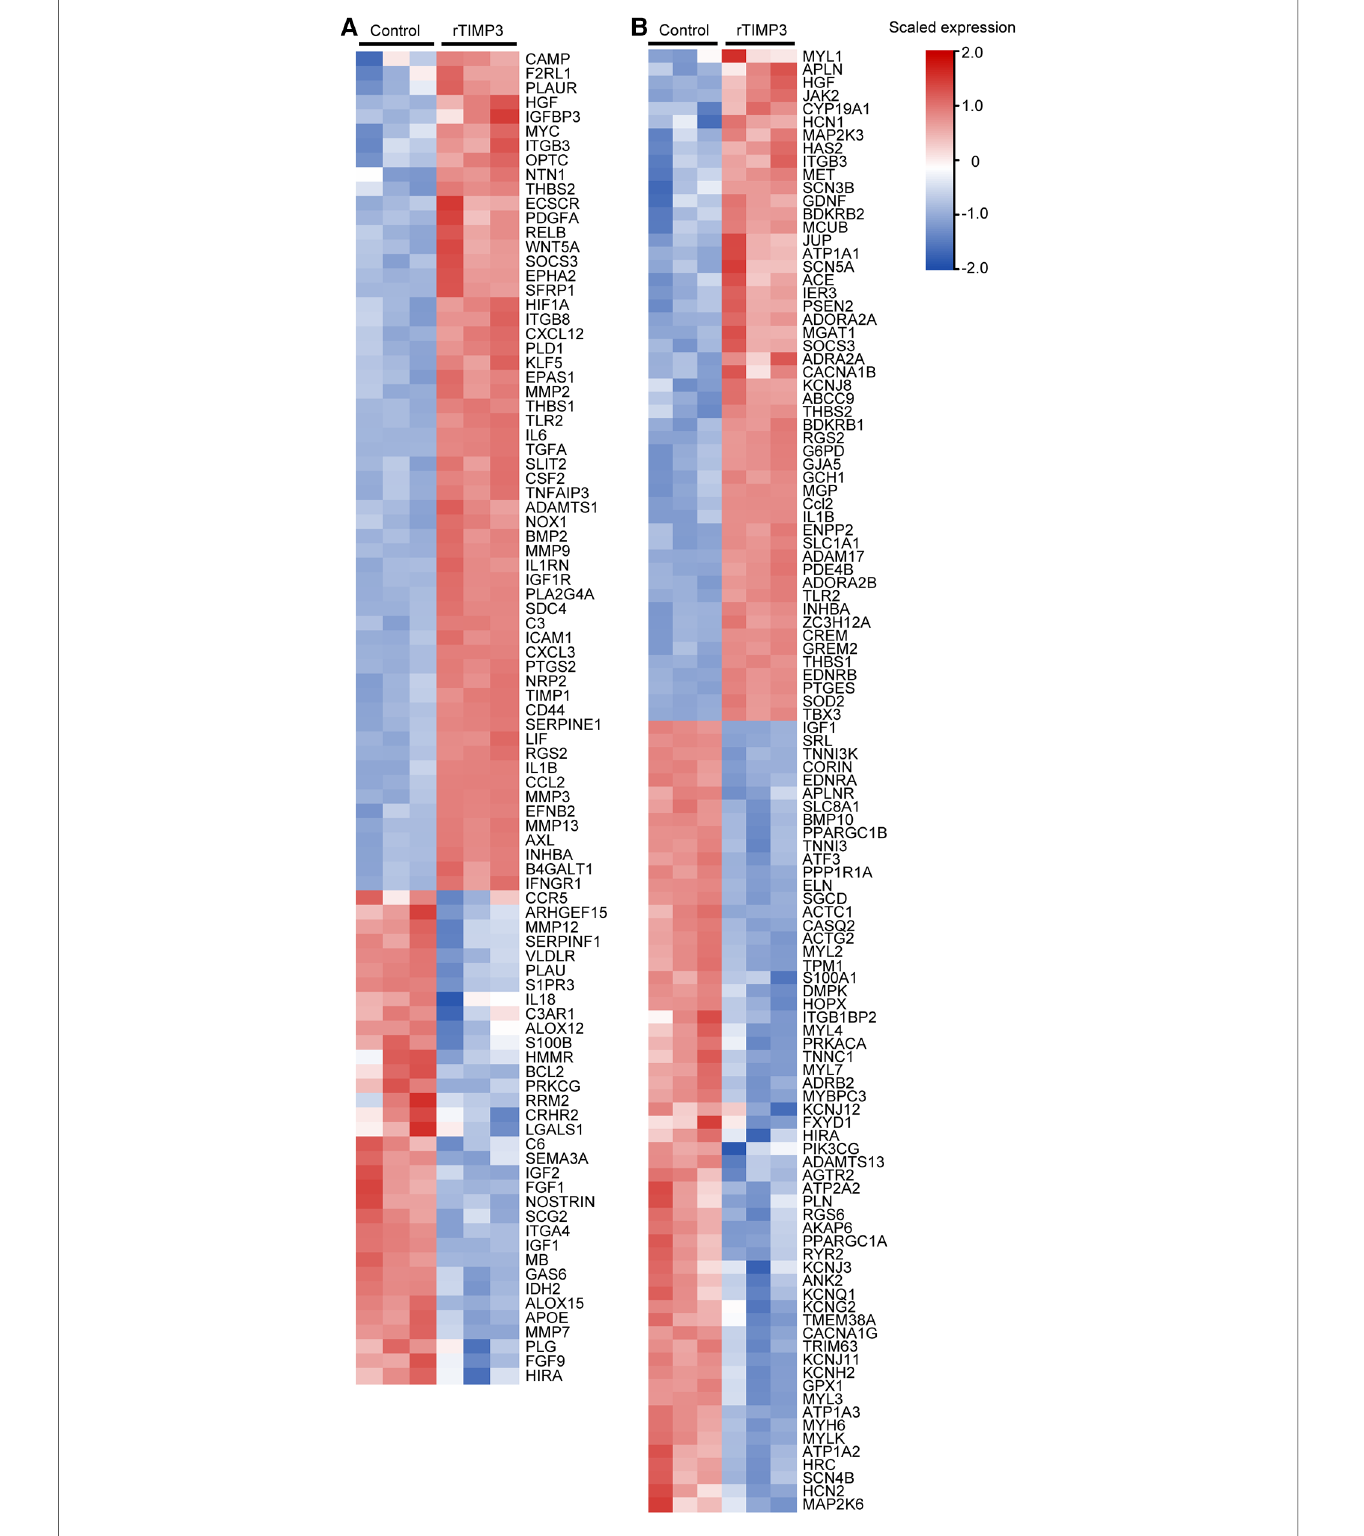
FIGURE 3 Some DEGs modulated by rTIMP3 were involved in regulation of vascularization and heart rate. DEGs regulated by rTIMP3 were predicted to increase vascularization ( A ) or to decrease heart rate ( B ) via Ingenuity Pathway Analysis (IPA) software, and their alterations were presented with heat maps illustrated by using